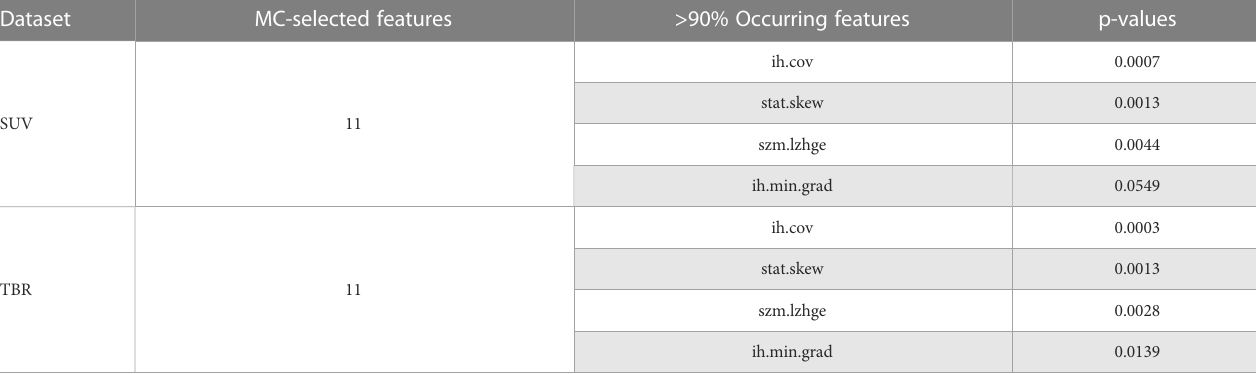
TABLE 3 Standardized uptake value (SUV) and tumor-to-background ratio (TBR) value-based glioma radiomic dataset characteristics to differentiate IDH+ and IDH- cases.